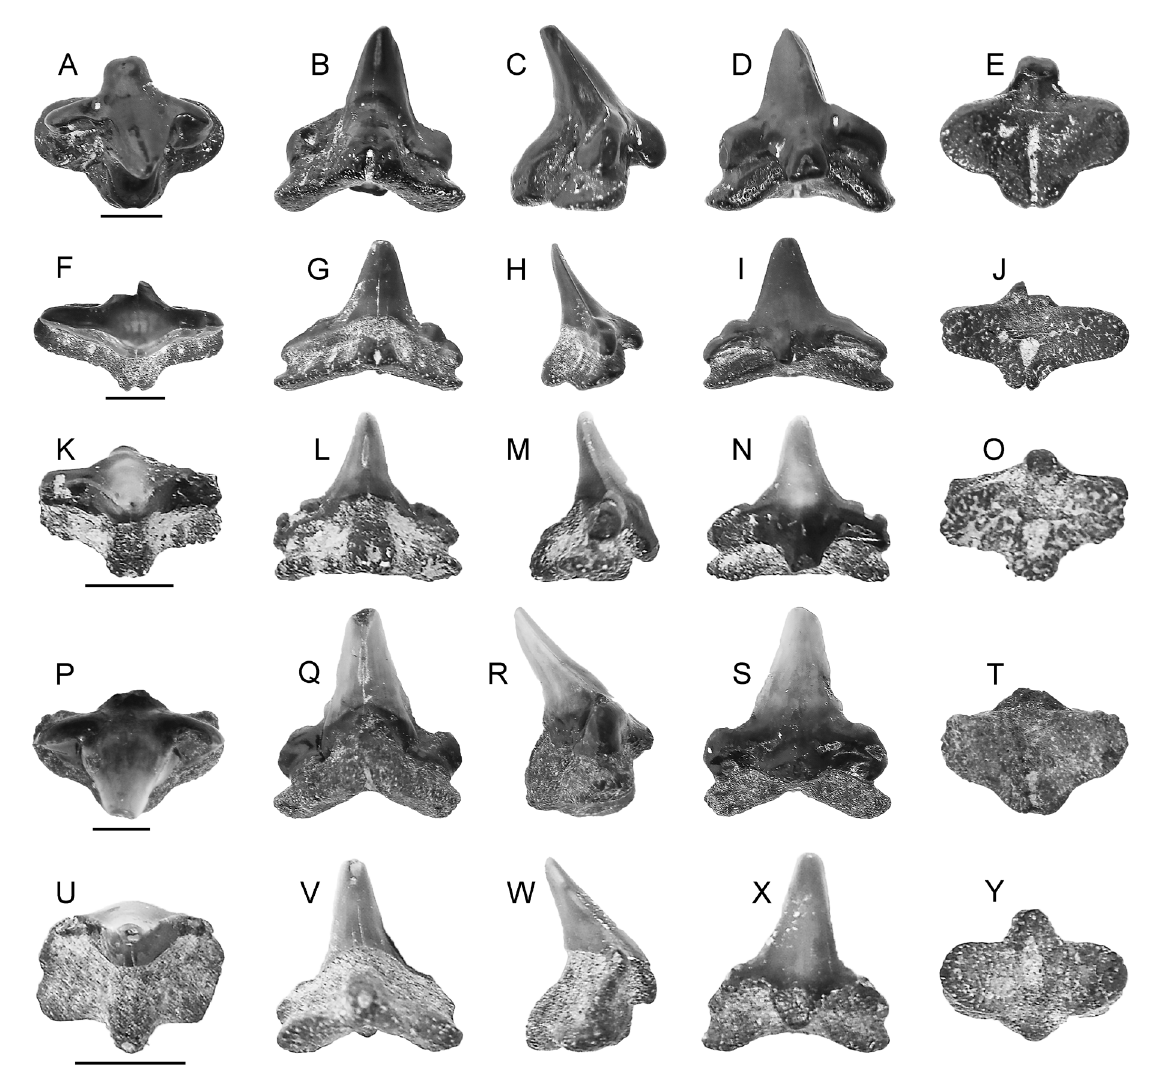
Fig. 6. Orectolobus ziegenhinei Cappetta & Case, 2016, teeth. A – E . MSC 37009, Tallahatta/Lisbon formation contact zone, courtesy of Carl Sloan. A . Oral view. B . Lingual view. C . Distal view. D . Labial view. E . Basal view. F – J . MSC 37181, Tallahatta/Lisbon formation contact zone, courtesy of T. Prescott Atkinson. F . Oral view. G . Lingual view. H . Distal view. I . Labial view. J . Basal view. K – O . MSC 37056.1, Tallahatta/Lisbon formation contact zone, courtesy of James Lowery. K . Oral view. L . Lingual view. M . Distal view. N . Labial view. O . Basal view. P – T . MSC 37319.1, basal Lisbon Formation. P . Oral view. Q . Lingual view. R . Mesial view. S . Labial view. T . Basal view. U – Y . MSC 37319.3, basal Lisbon Formation. U . Oral view. V . Lingual view. W . Mesial view. X . Labial view. Y . Basal view. Labial at top in oral and basal views. Scale bars = 2